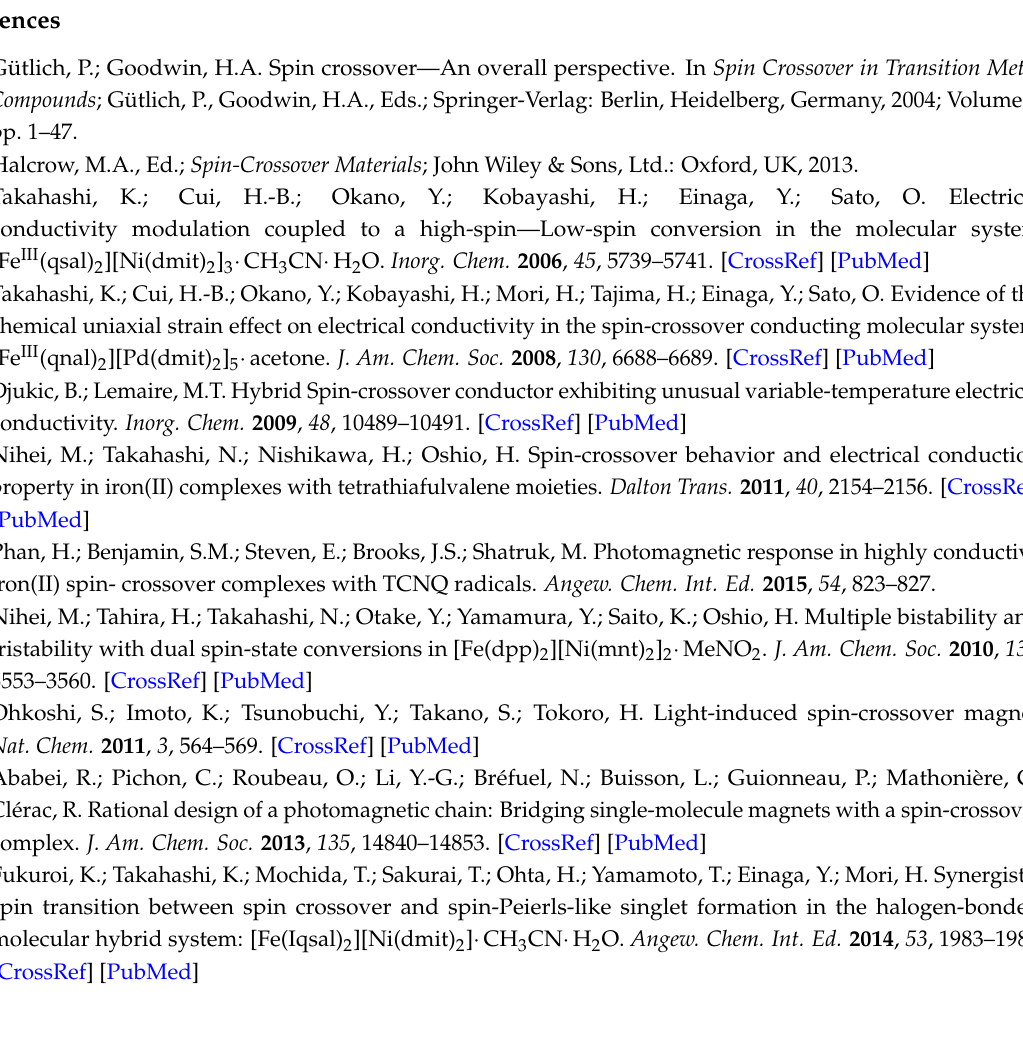
Table S1: Cartesian coordinates of the HS [Fe(aznp) 2 ] anion, Table S2: Cartesian coordinates of the LS [Fe(aznp) 2 ] anion, 3.cif: Crystal analysis data for compound 3 , 4_CB.cif: Preliminary crystal analysis data for compound 4 ¨ C 6 H 5 Cl, 5.cif: Preliminary crystal analysis data for compound 5